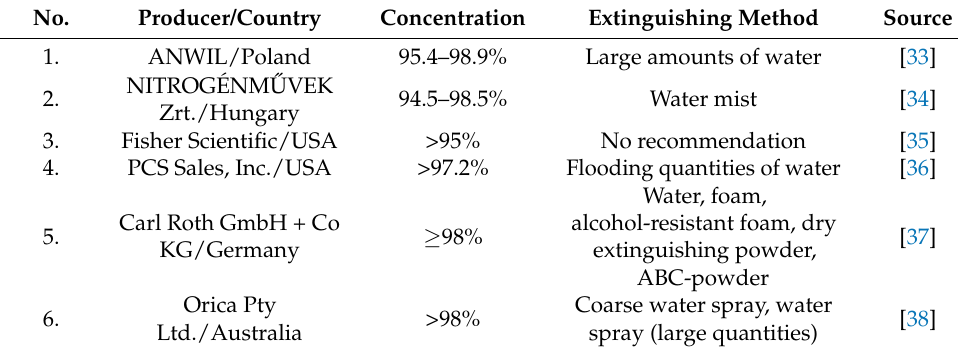
Table 6. AN extinguishing recommendation by different